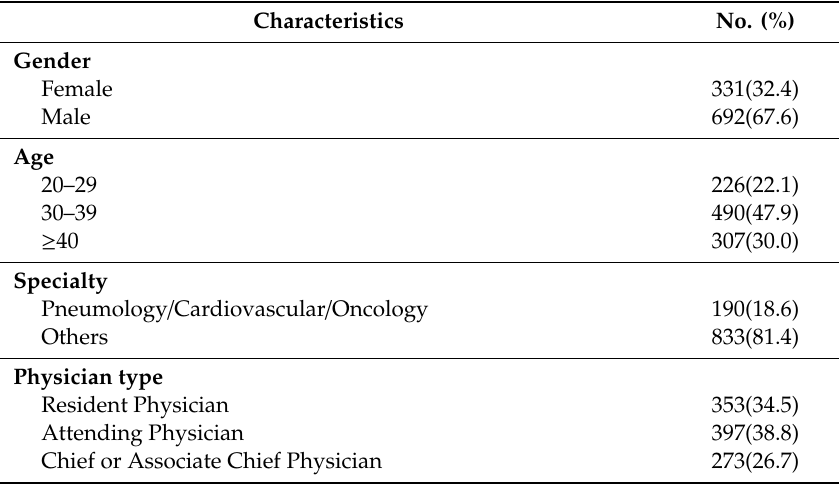
Table 1. Demographics and other characteristics of